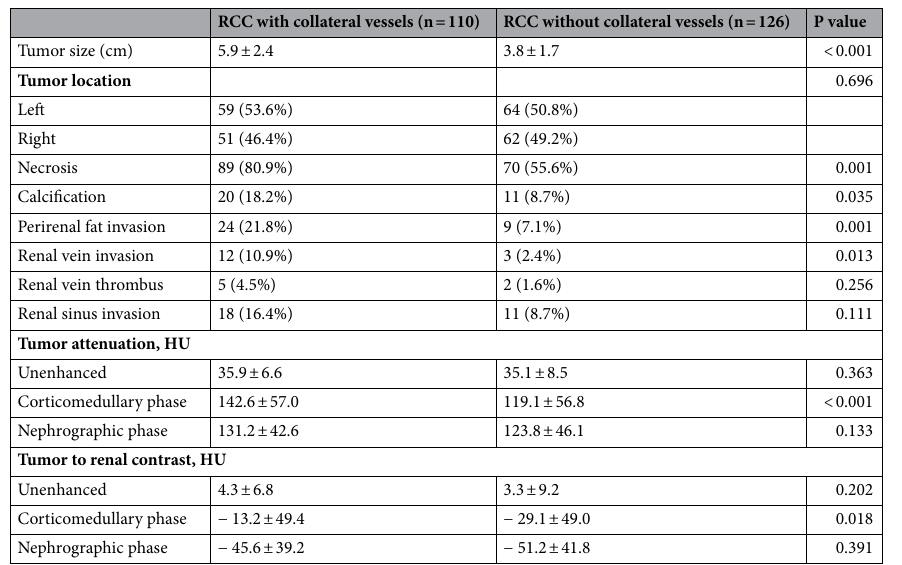
Table 4. Imaging characteristics of RCC with and without collateral vessels. RCC renal cell carcinoma; HU Hounsfield Unit.